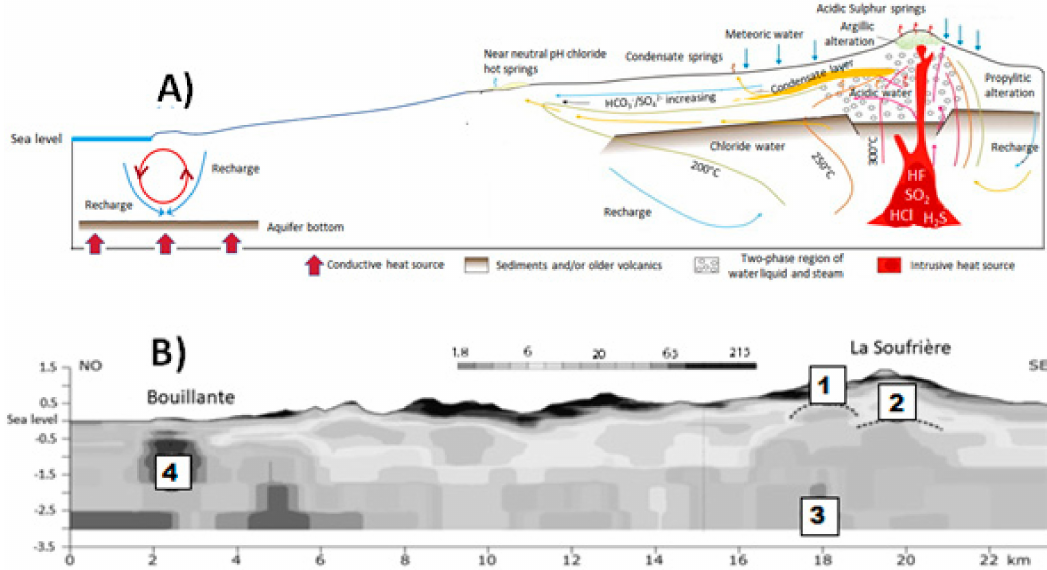
Figure 6. ( A ) Geothermal sketch related to an active volcanic field typical for an island arc setting above a subduction zone and approximating the Soufri è re–Bouillante sectors of Basse-Terre in Guadeloupe (modified from Moeck, 2014 [64]). ( B ) Magneto-telluric (MT) cross-section along La Soufri è re et Bouillante sectors showing a well-defined dome-shaped horizon with conductive properties (1), a deep upflow likely rising from La Soufri è re magma chamber (2), a deep resistive zone in the Soufri è re roots (3), which could correspond to a potential heat reservoir, and a well-resolved resistive unit associated with the Bouillante reservoir (4) (modified from Raguenel et al. 2019 [53]). The MT section of ( B ) can thus be interpreted in line with the schematic representation in ( A